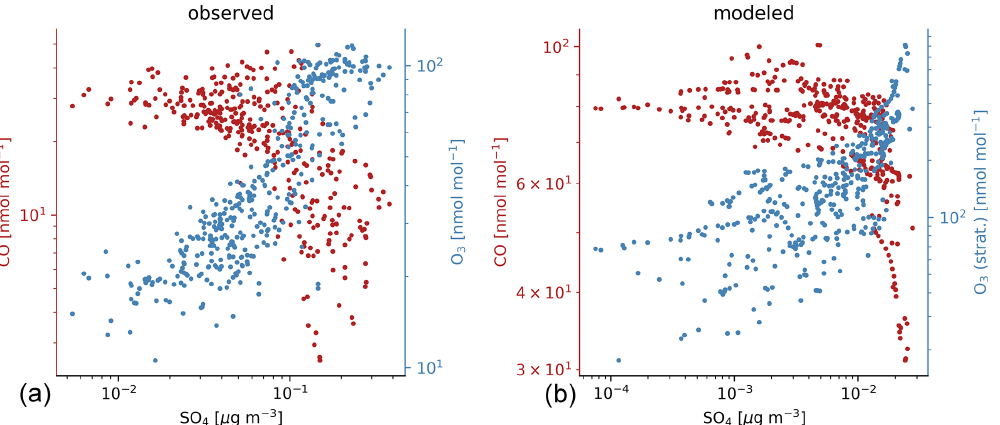
Figure 4. Scatter plot of co-located SO 4 , CO (red), and O 3 (blue) abundance between 350 and 150hPa from observations (a) and the RED simulation (b)